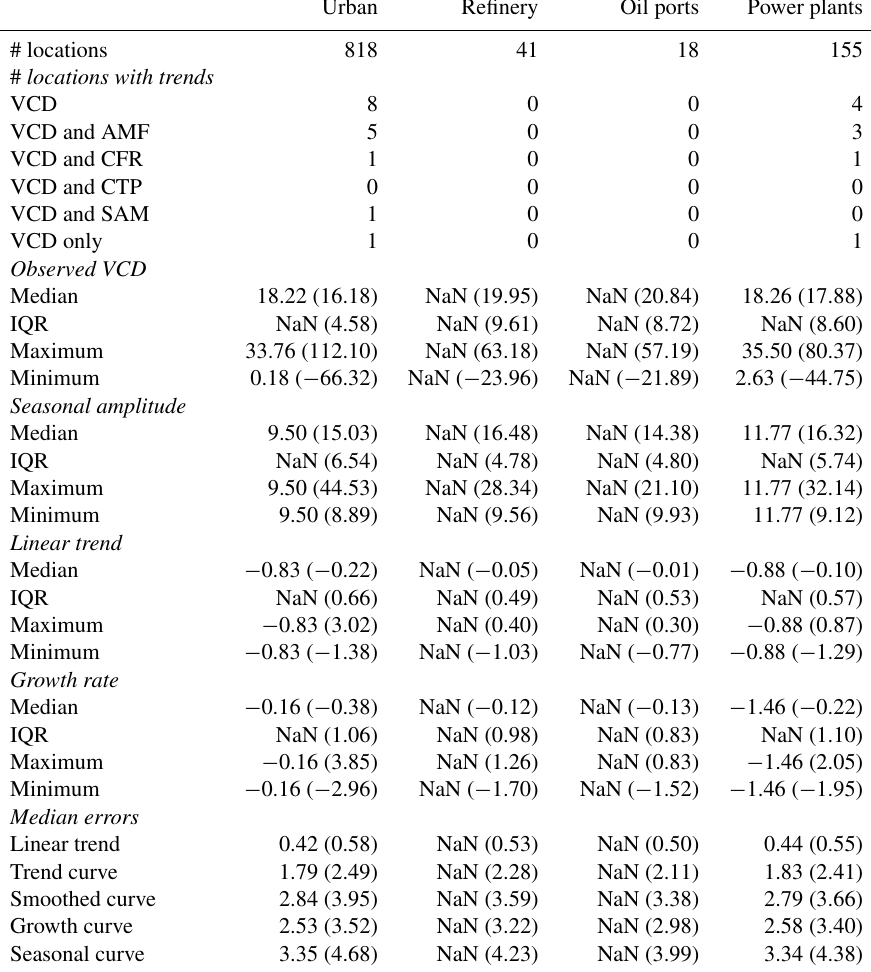
Table 4. Statistical summary of the BIRA CHOCHO vertical column density (VCD) analysis conducted at an approximate 10km radius over the target locations. Statistical values are shown for those locations which have a real VCD trend, i.e. those locations without a corresponding trend in either the air mass factor (AMF), cloud fraction (CFR), cloud-top pressure (CTP), or number of samples (SAM). Values in parenthe- ses correspond to statistics for all locations of a given category. VCD values are given in 10 13 moleculescm − 2 , and IQR is the interquartile range. Values which cannot be computed are represented by NaN (not a